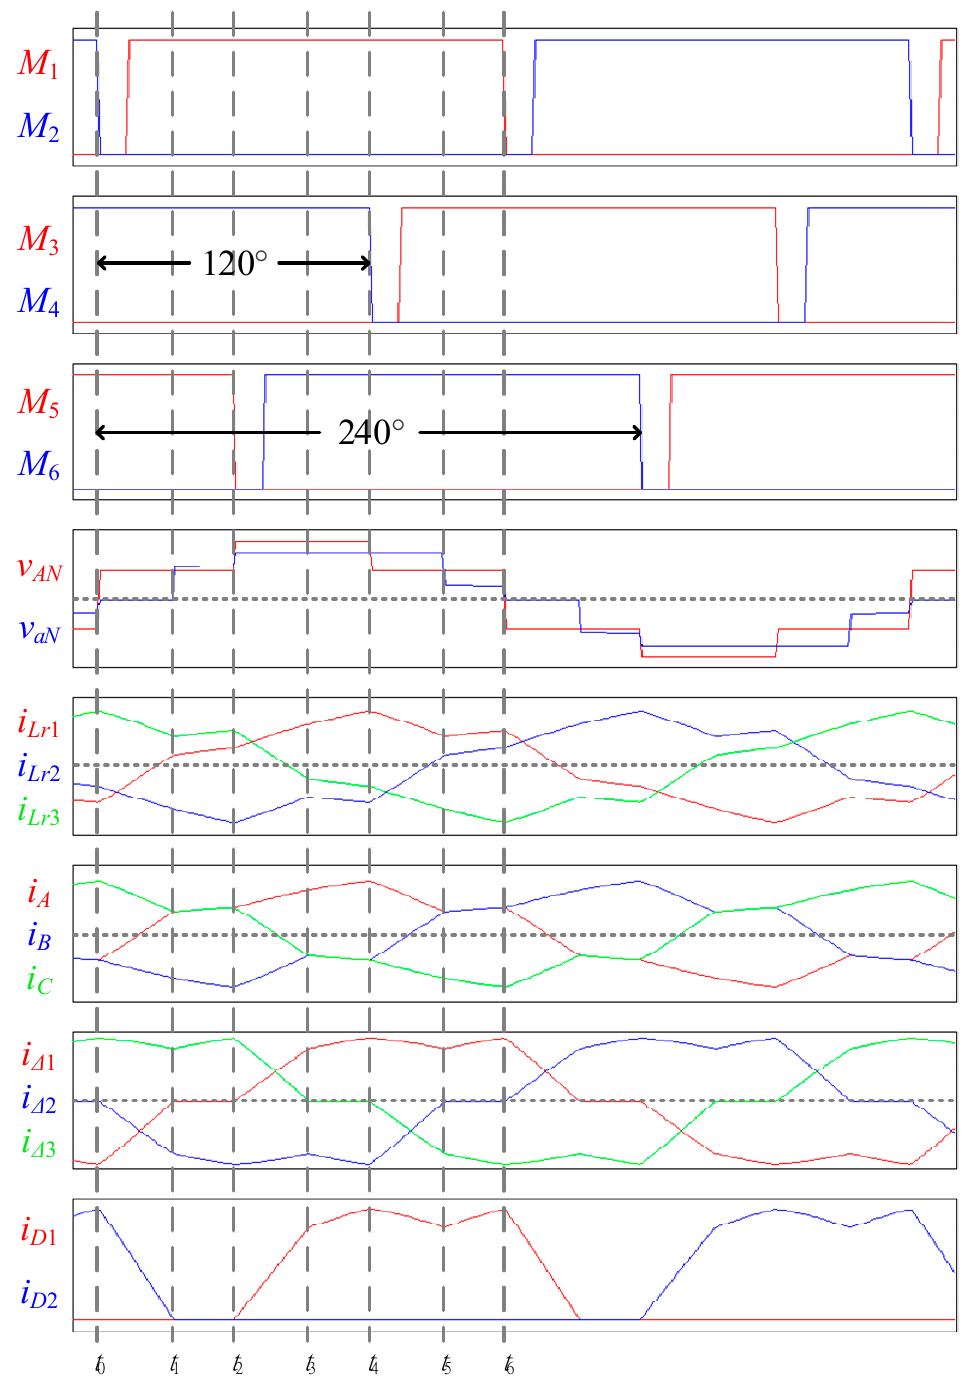
Figure 3. Operation station of three-phase wye–delta LLC.